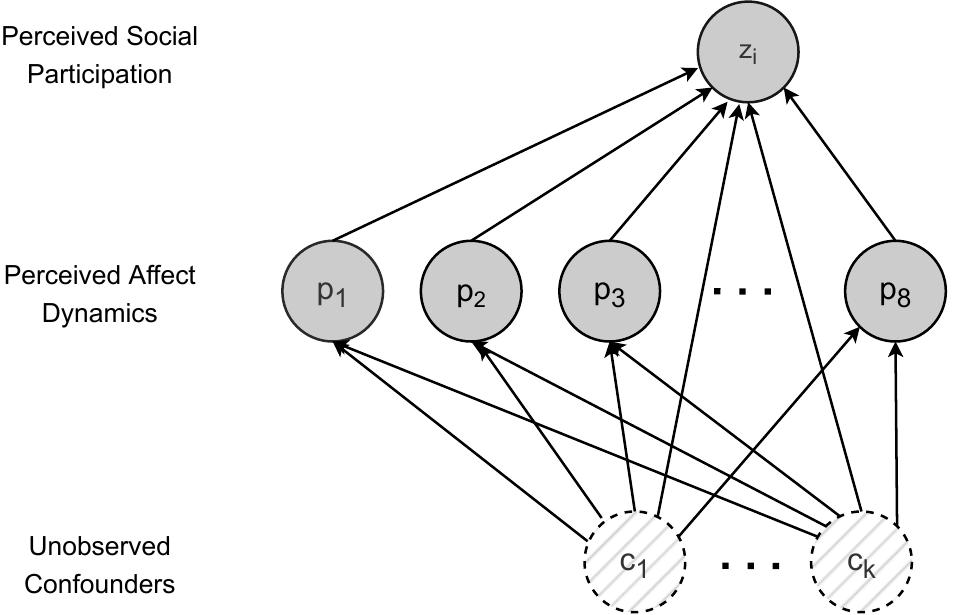
Figure 3. The assumed causal graph. The apparent (perceived) social behaviour is caused by the many variables describing affect dynamics. Both, though, may be subject to a set of unobserved common causes